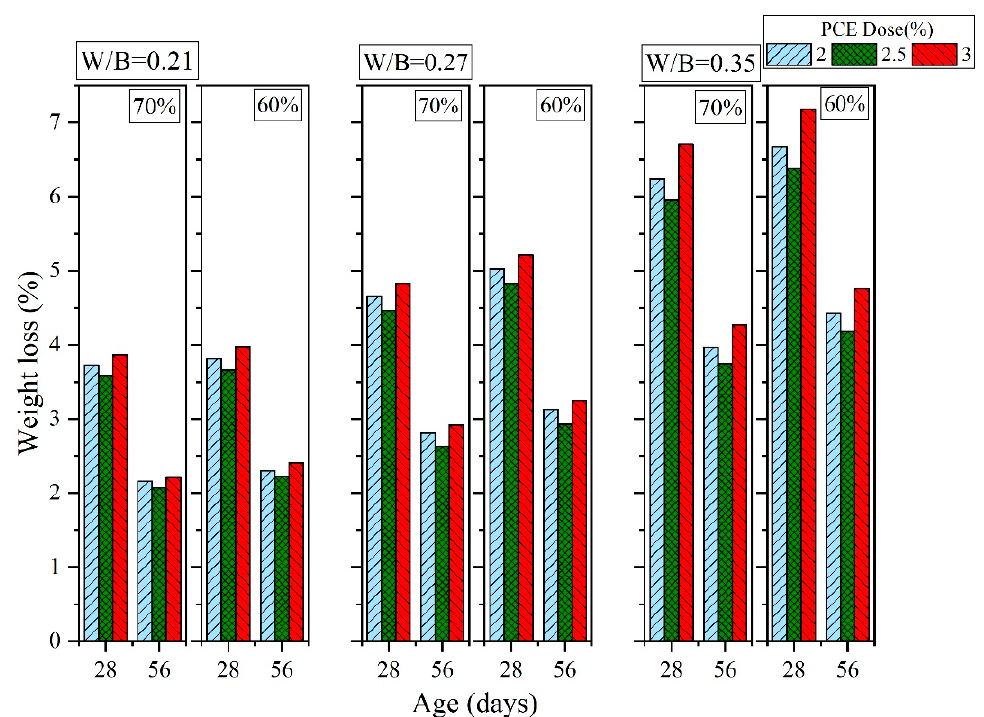
Figure 16. Sulfate resistance of green and ecofriendly grouting material with PCE.